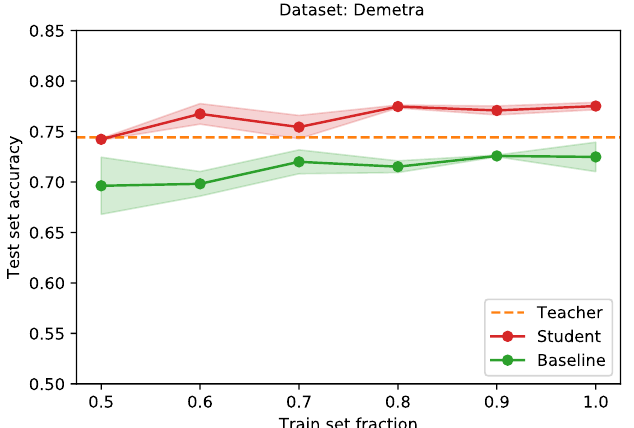
Figure 9. Comparison of the average test set accuracy when training a neural network, with and without knowledge distillation, as a function of the student train set size. The teacher network is trained using the ISIC train set, of 24,064 images. The student and baseline networks are trained using fractions of the Demetra train set (having a total of 5156 images). Averages over three runs. Shaded areas indicate the standard